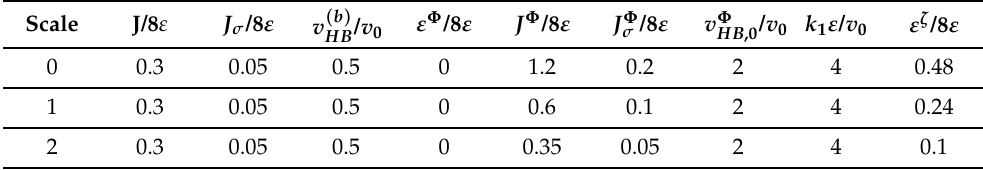
Table 1. The three sets of parameters—here called Scales—considered in this work for the coarse- grained proteins, hydrated by the Franzese–Stanley water model. The three sets differ only for the values of ε Φ , J Φ , and J Φ σ , associated with the water hydrating hydrophobic interfaces/residues. Symbols are defined in the text.